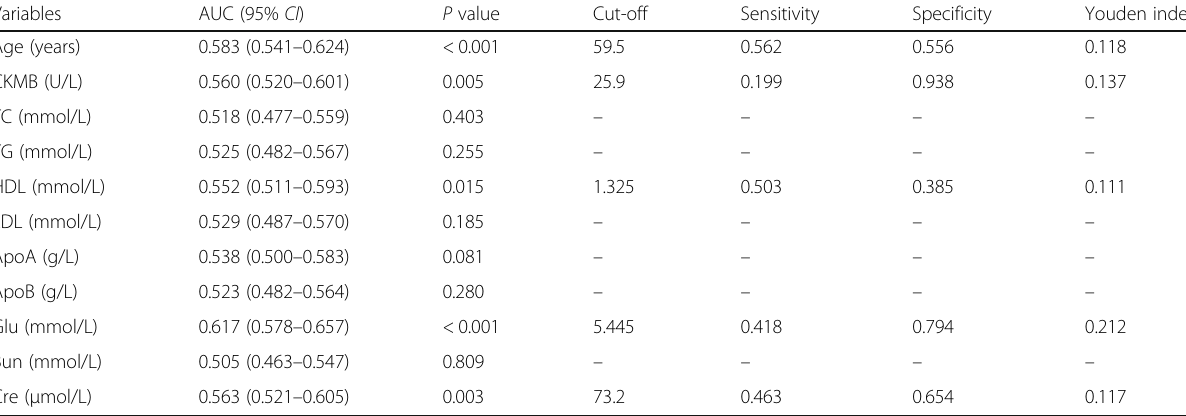
Table 7 Receiver operating characteristic curve analyses for predicting CHD prevalence